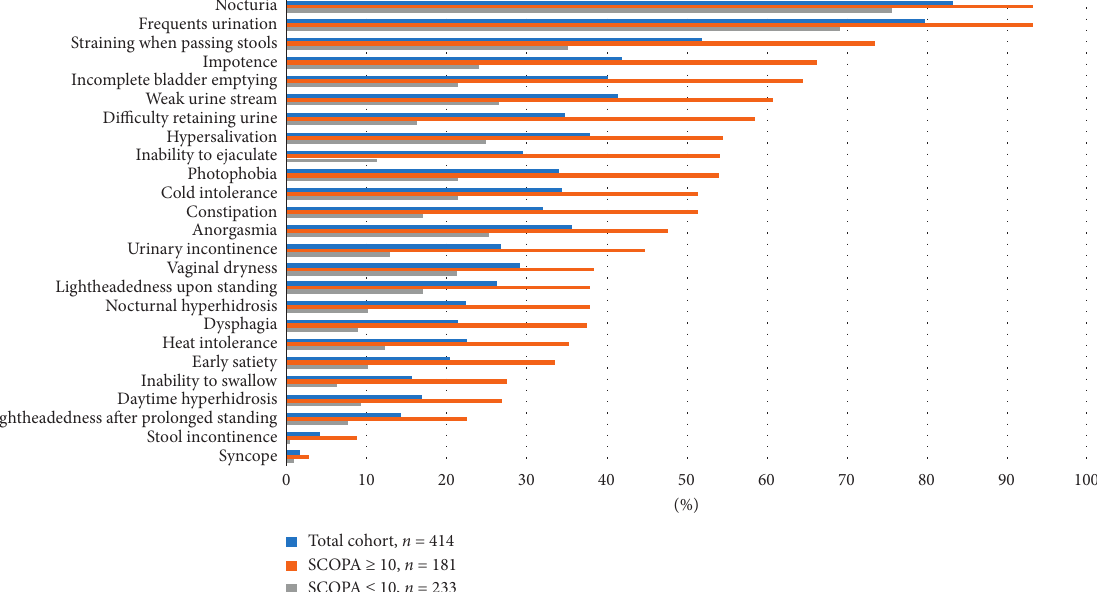
Figure 1: Prevalence of SCOPA-AUT items in our PD cohort. SCOPA-AUT: Scales for Outcomes in Parkinson’s Disease-Autonomic dysfunction; PD: Parkinson’s disease.